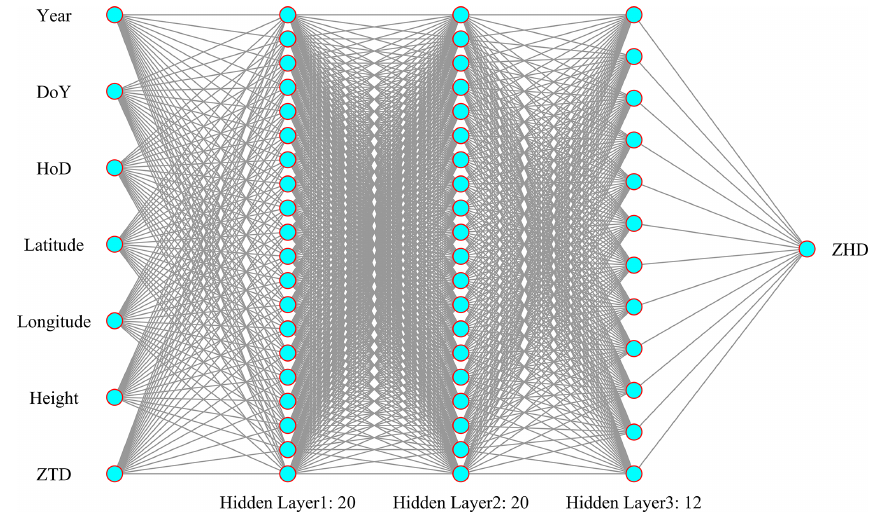
Figure 4. Structure of BP-ANN used in this